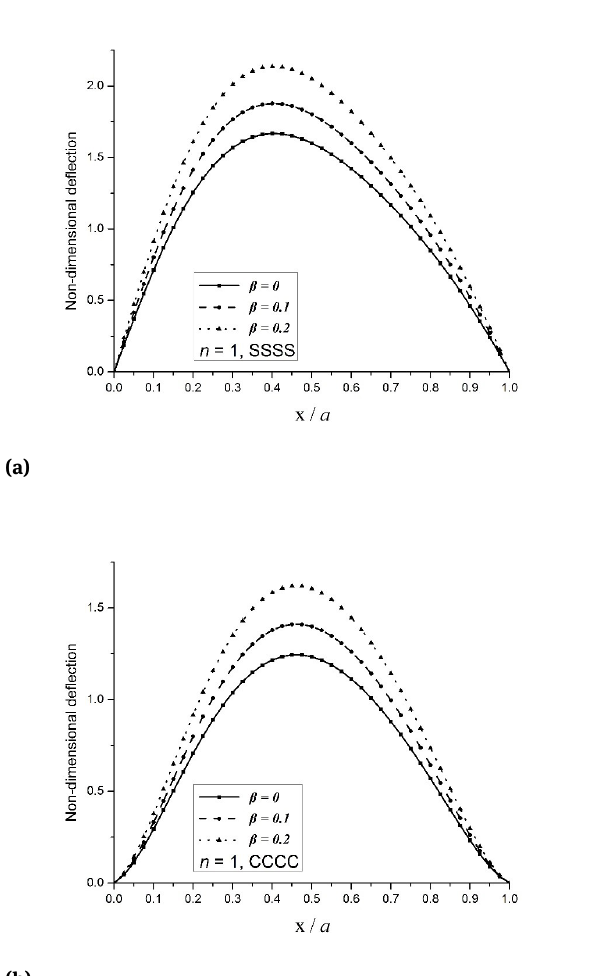
Figure 3: Variation of non-dimensional deflection of FGM-1 porous conoidal shell under uniform